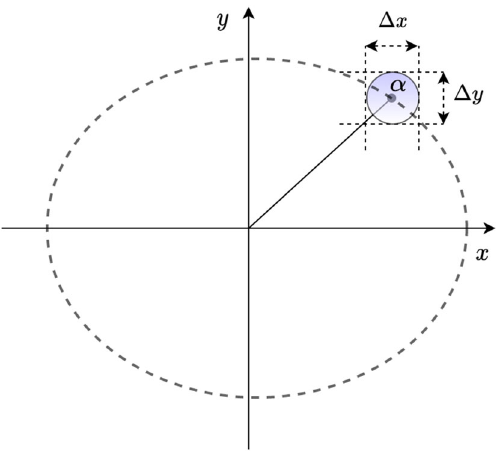
Fig. 2 The phase space of a simple harmonic oscillator. The coherent state | α (cid:5) saturatestheHeisenbergbound (cid:11) x (cid:11) y = ¯ h / 2.Thelargeellipse representsthetimeevolutionof | α (cid:5) evaluatedusingSchrodinger’sequa- tion and coincides with the trajectory of a classical oscillator. The small circle is the region of uncertainty around the classical phase space point whose co-ordinates are given by (cid:4)ˆ x (cid:5) = Re (α), (cid:4)ˆ y (cid:5) = Im